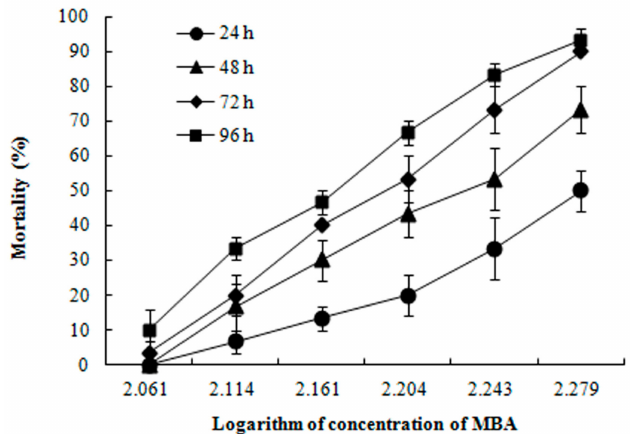
Figure 1. Mortality of juvenile P. clarkii exposed to mixture of bensulfuron-methyl and acetochlor (MBA) at 24, 48, 72 and 96 h (Mean ± SE). No death was noted in the water control